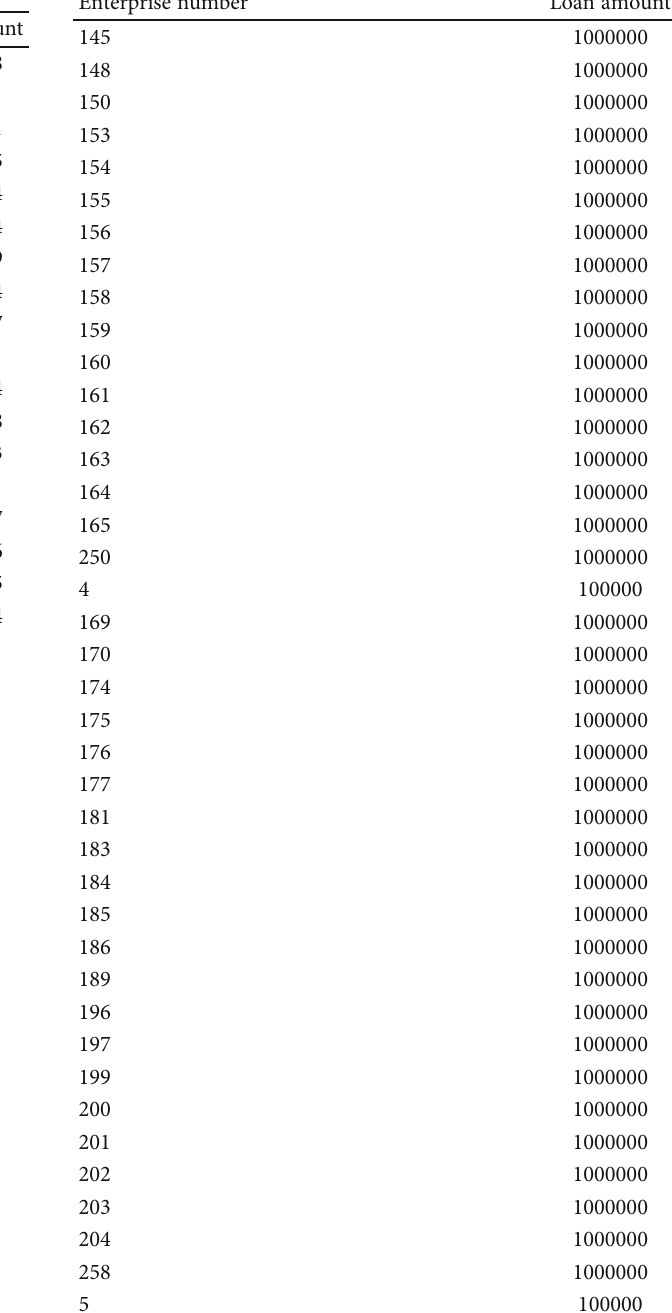
Table 6: List of the speci fi c amount of 100 million yuan loan from the bank to 302 SMMEs